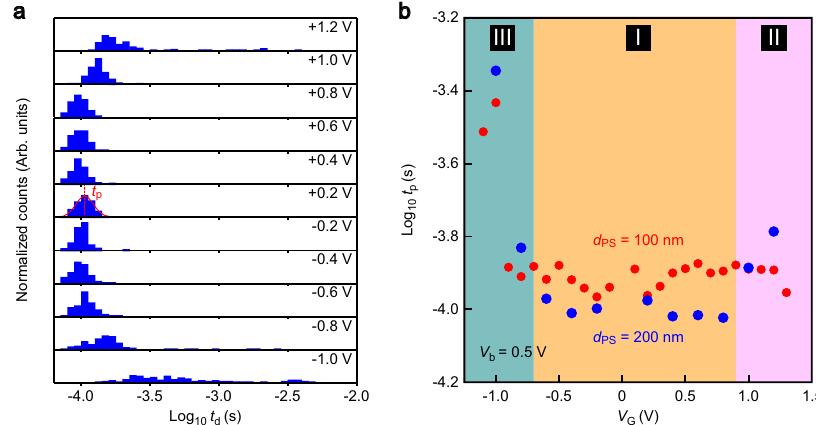
Fig. 2 Gate voltage dependence of the translocation time of single nanoparticles. a Histograms of t d at different V G conditions from − 1.0 to + 1.2 V under V = 0.5 V. Red curve displays Gaussian fi tting that de fi nes t b nanobeads.